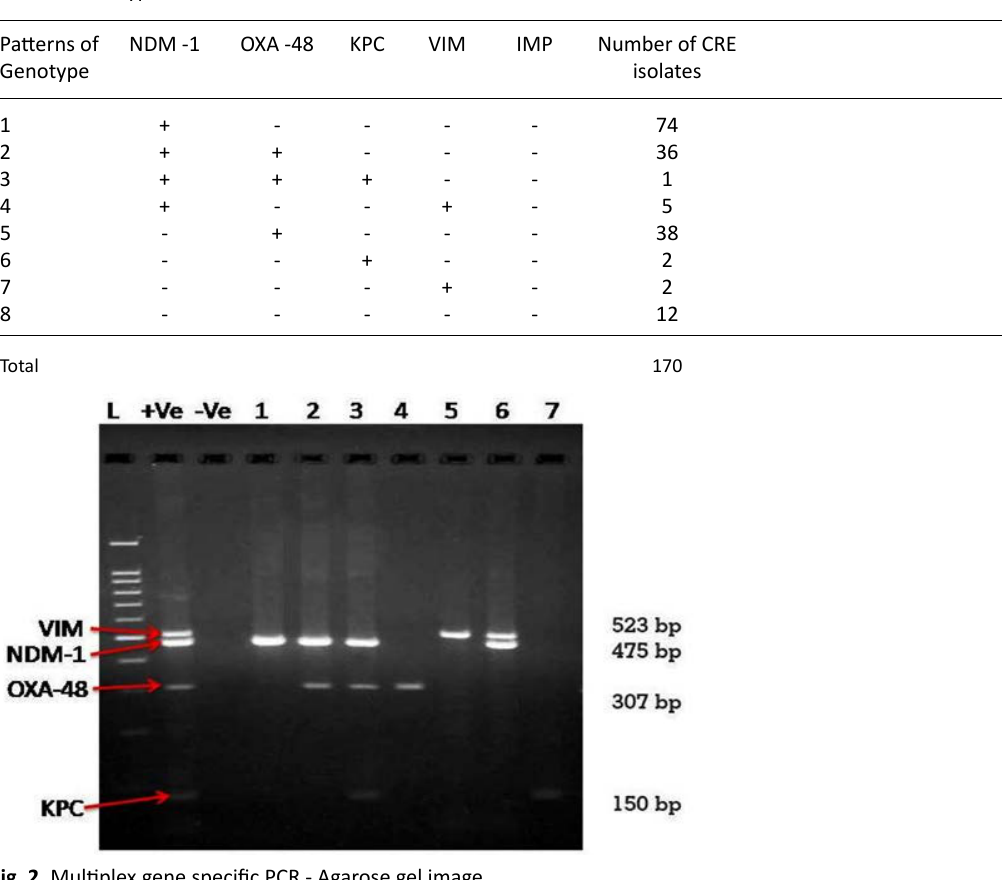
Fig. 2. Multiplex gene specific PCR - Agarose gel image Lane L: 100 bp DNA ladder, Lane +Ve- Positive control, Lane -Ve-Negative control and Lanes 1 to 8:Clinical isolates for Carbapenem Resistant Enterobacteriaceae family showing presence or absence of carbapenemase encoding genes. Lane 1- NDM-1 Positive, Lane 2-NDM-1 & OXA-48 Positive, Lane 3- NDM-1,OXA-48 & KPC Positive, Lane 4 –OXA -48 Positive, Lane 5- VIM positive, Lane 6 - VIM & NDM-1 positive, Lane 7 - KPC